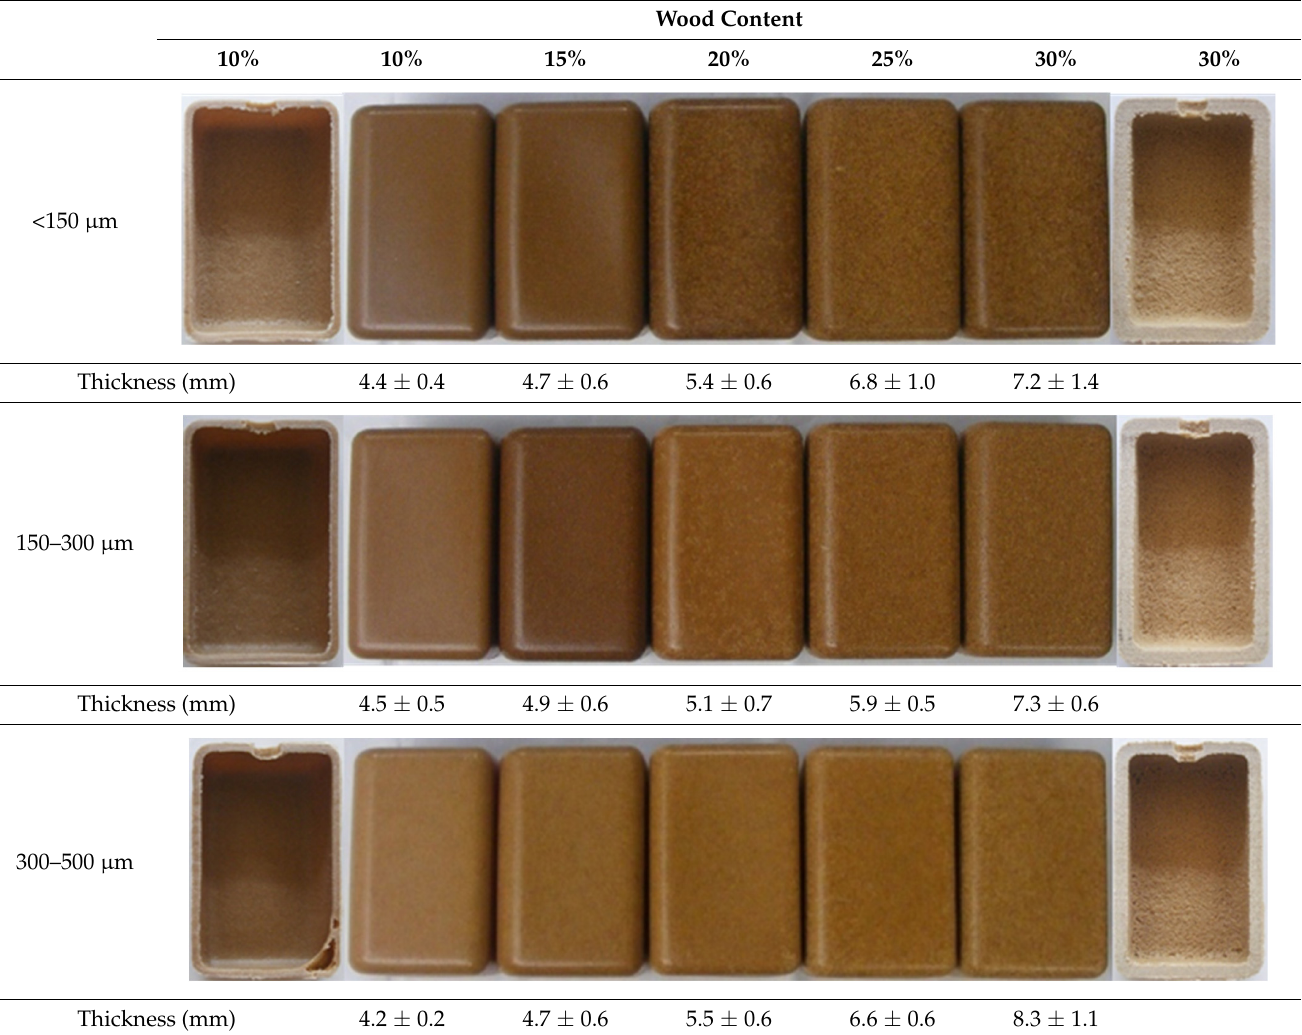
Table 6. Effect of wood granulometry and wood content on the surface characteristics of PE/wood parts.